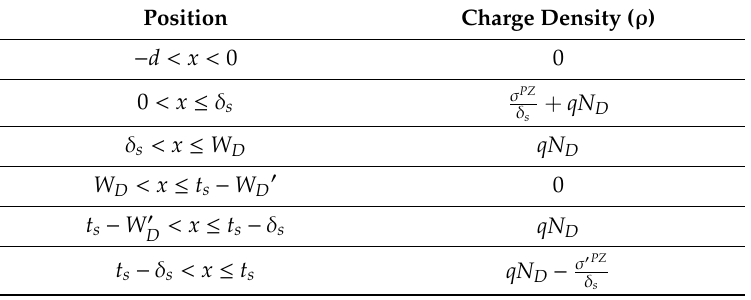
Table A6. Charge density distribution of the piezoelectric MIS structure.